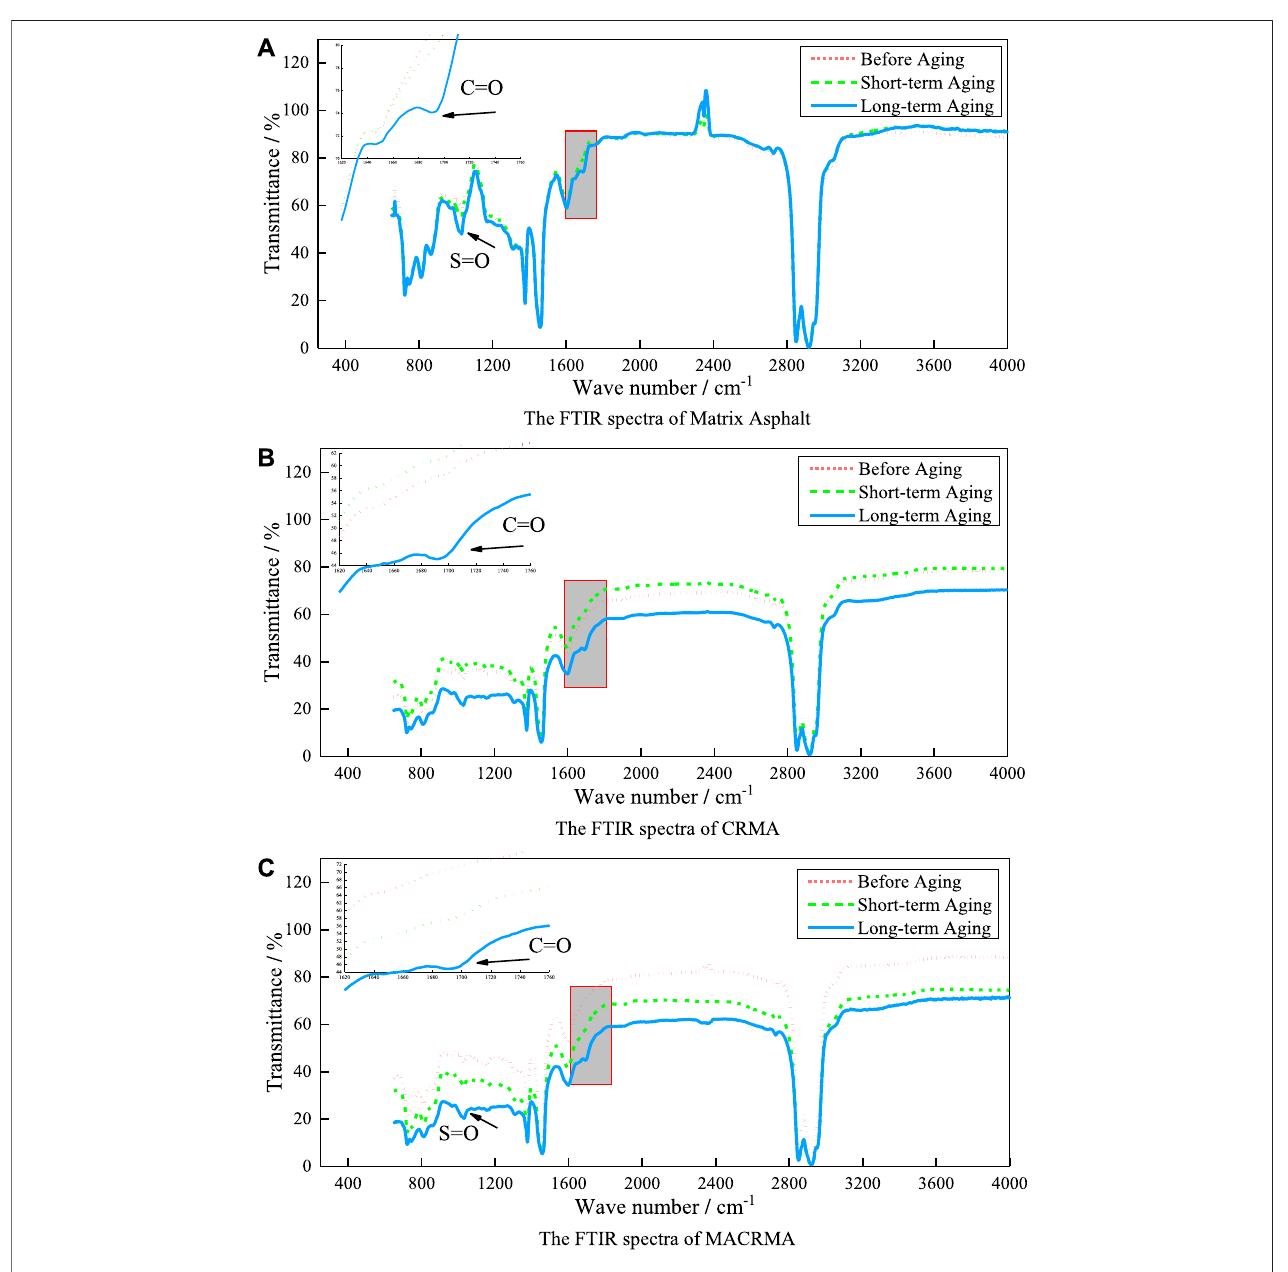
FIGURE9| ChangesintheFTIRspectraofthreekindsofasphaltbeforeandafteraging. (A) TheFTIRspectraofMatrixAsphalt, (B) TheFTIRspectraofCRMA, (C) The FTIR spectra of MACRMA.